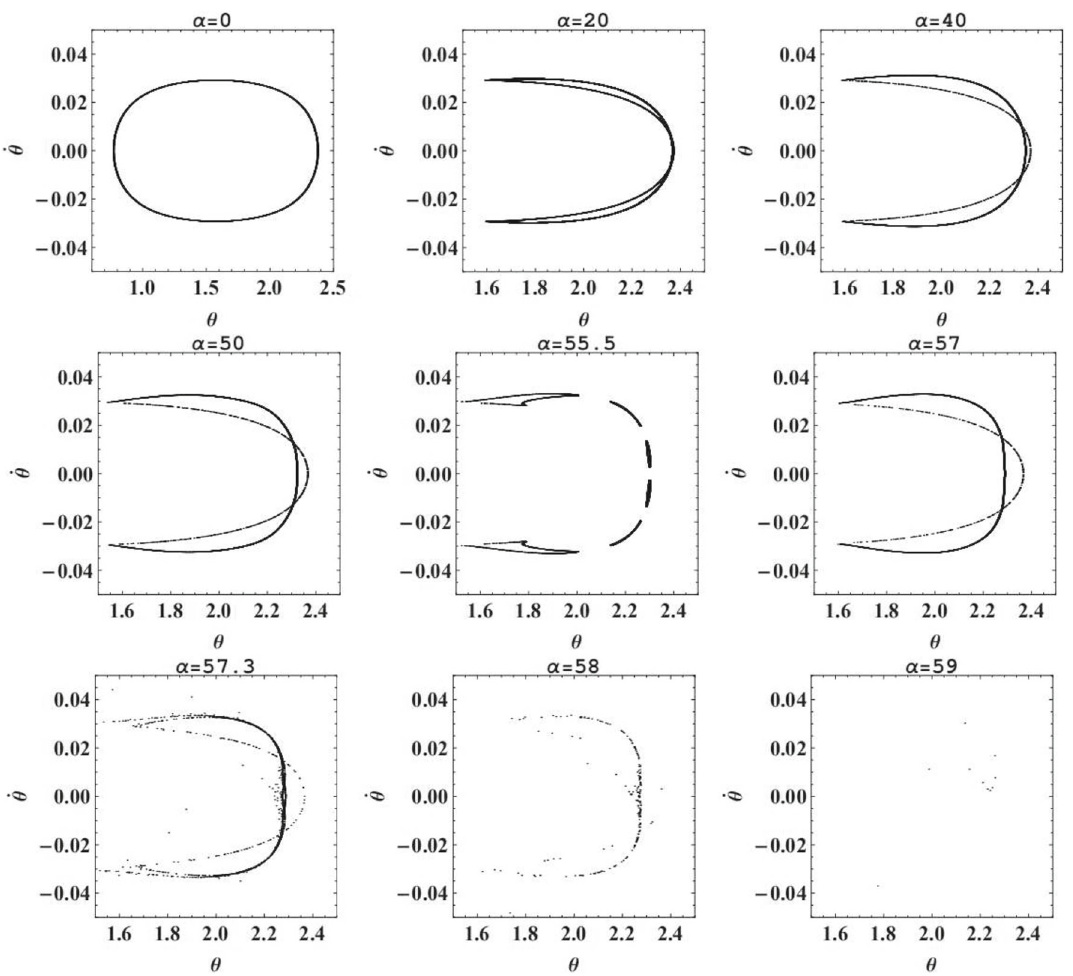
Fig. 5 The Poincaré surface of section ( ˙ r (τ) = 0) in the plane θ − ˙ θ with different α for the signal plotted in Fig.